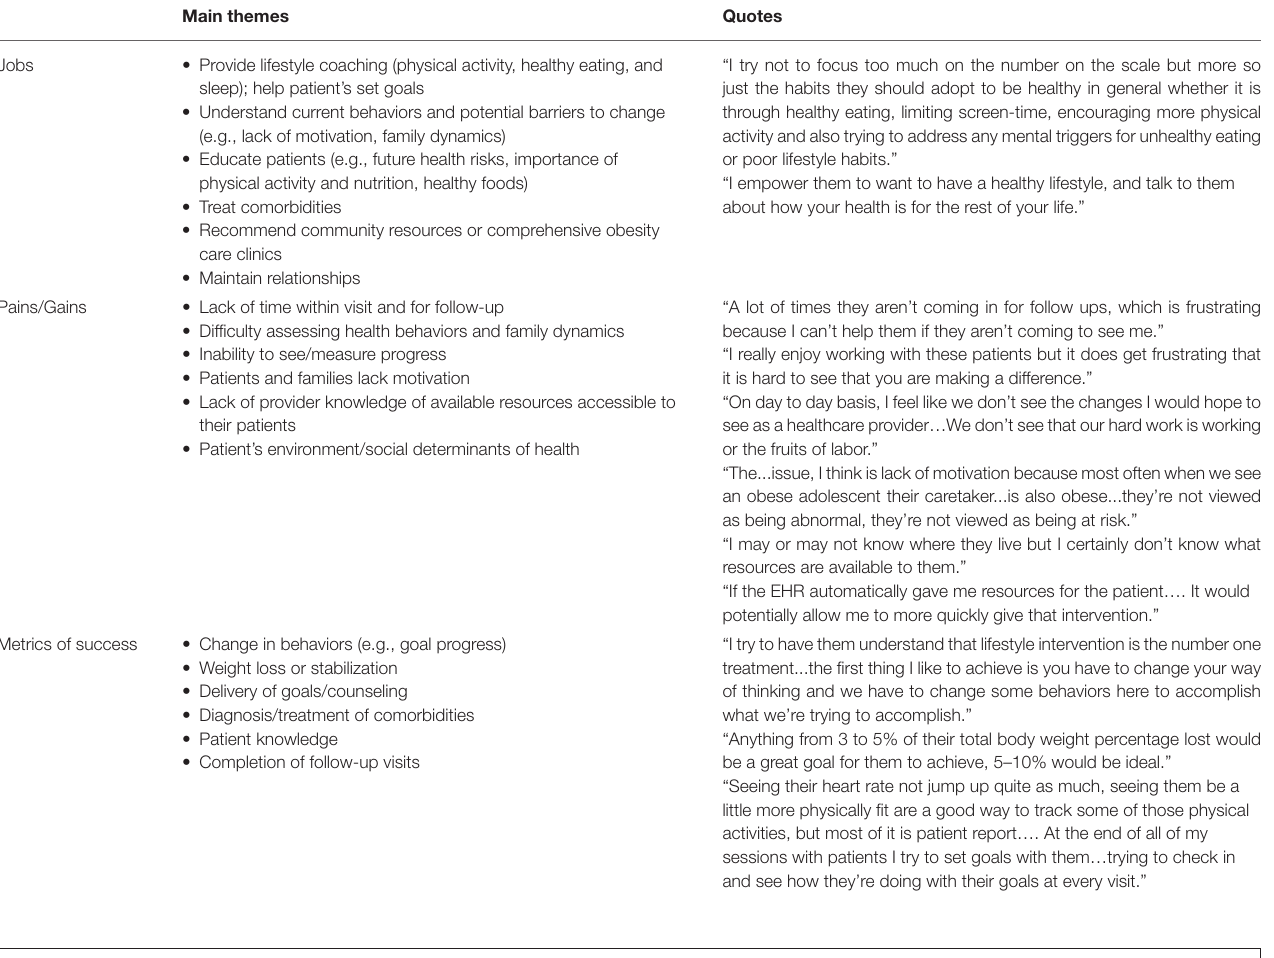
TABLE 1 | Summary of customer discovery results.